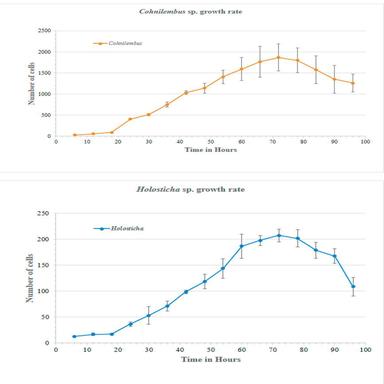
(a and b). a).The growth of ciliates. a). ciliate, Cohnilembus sp. was able to grow rapidly with high cell numbers in the media added wheat seeds. b). The Holosticha sp. was slow in their growth rate with low in cell numbers. Both the ciliates showed a rapid increase.